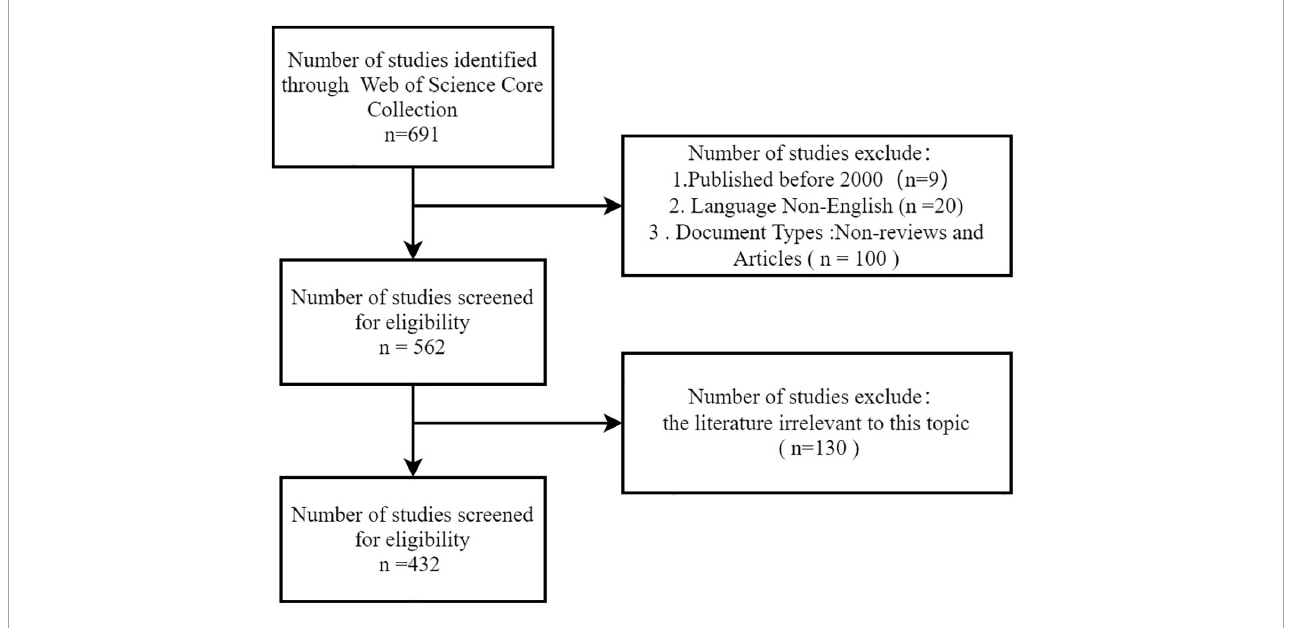
FIGURE1 Flow diagram of literature search and